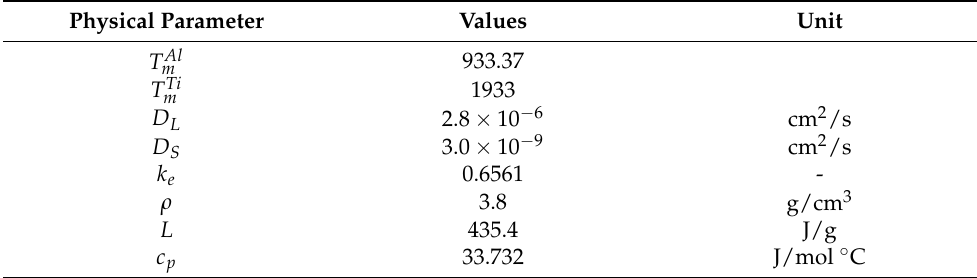
Table 1. Physical properties of Ti-4.5% Al alloy [44]. Physical Parameter